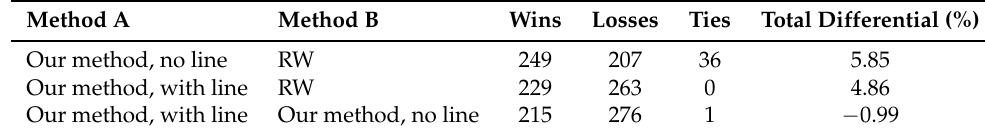
Table 4. Dataset 1 [4]: pairwise comparison of methods with per-class